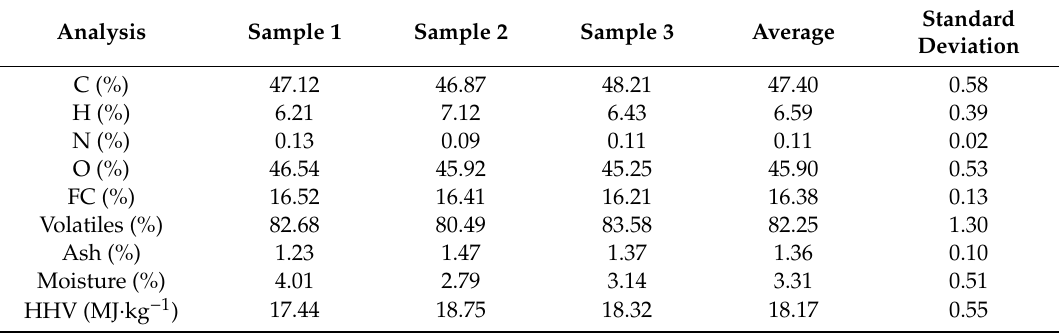
Table 4. Results obtained in the analysis conducted with dried samples. FC, fixed carbon; HHV, higher heating